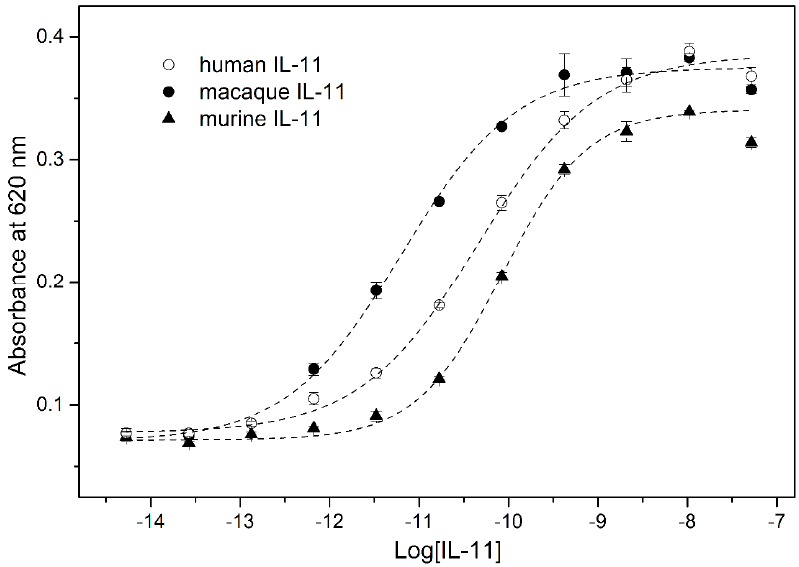
Figure 7. IL-11-induced STAT3 activation in a HEK-Blue™ IL-6 cell line transfected with human IL-11R α gene, monitored by STAT3-induced secretion of SEAP (QUANTI-Blue™ assay) for murine, macaque and human rIL-11. Standard deviations estimated from the duplicate measurements are shown. The dashed curves are theoretical fits to the experimental curves using Boltzmann function.